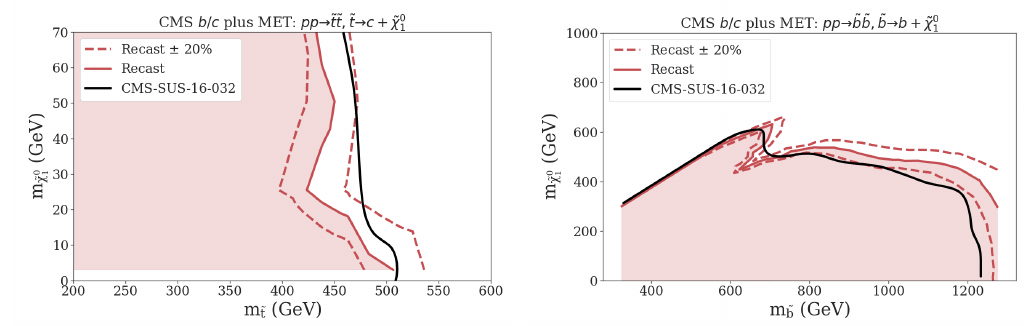
Figure 19 . Validation of the CMS search for missing energy in association with b − or c − jets [56] implemented using CheckMATE 2 . The solid black line shows the official exclusion curve, while the solid red curve shows the one obtained through recasting. The left panel shows the results obtained for the compressed stop simplified model, while the right panel displays the results obtained in the sbottom